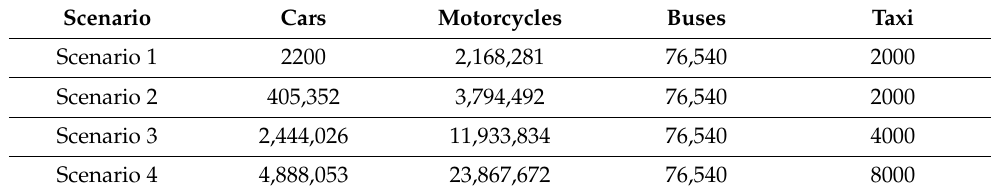
Table 1. Java-Bali EV uptake scenarios.